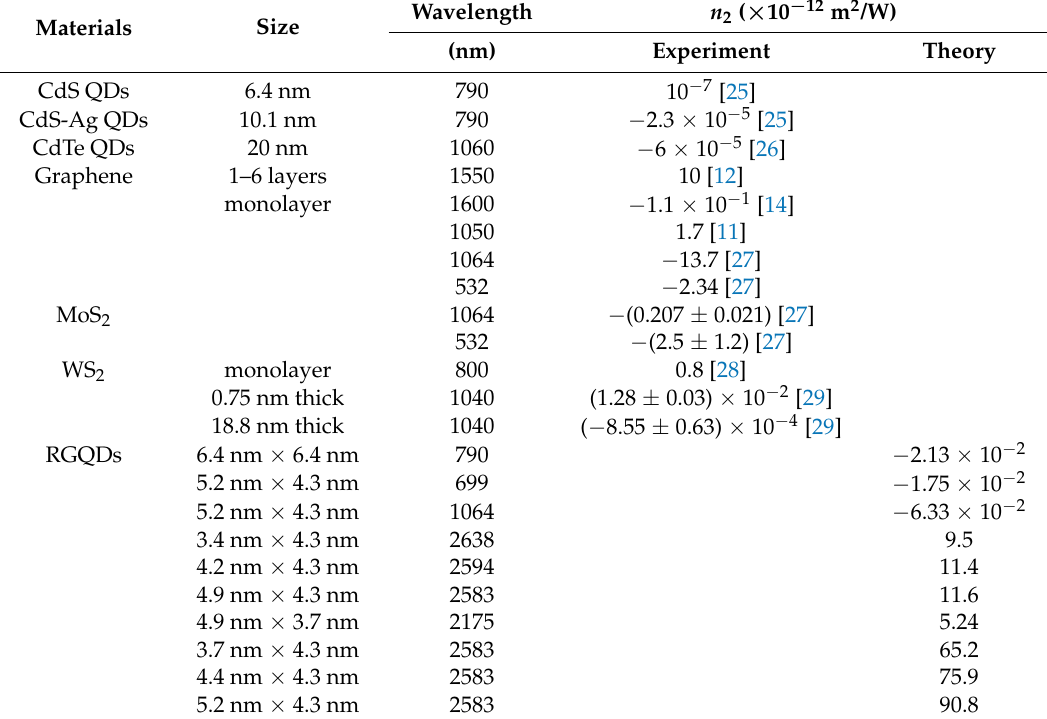
Table 1. Calculated n 2 in RGQDs and experimental data in other related materials for comparison. Materials